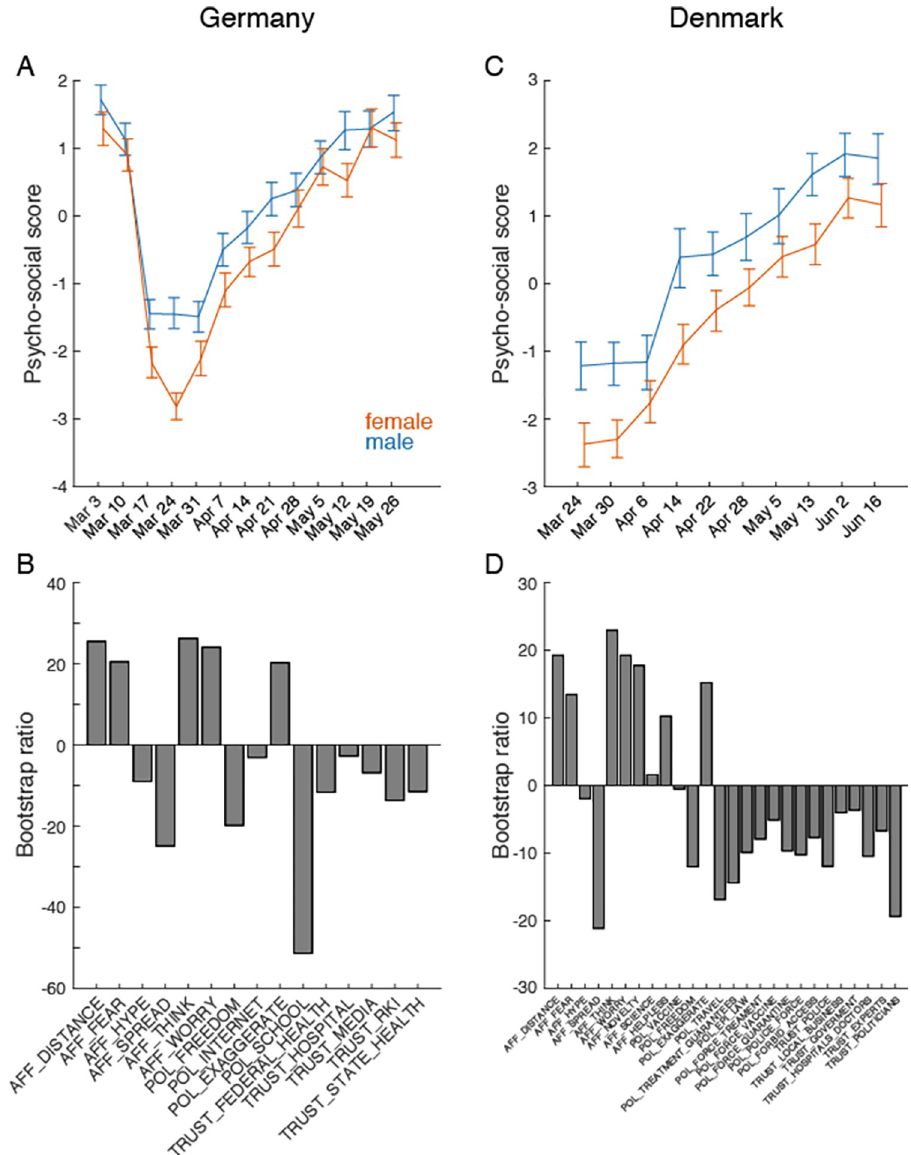
Fig 5. Sex differences in PS indicators. The dominant effect (both p < 0.001 from permutation test) of a multivariate Partial Least Squares analysis of mean change over time of PS indicators in COSMO data from Germany (A-B) and Denmark (C-D) by sex. AFFECT (AFF), POLICY (POL) and TRUST variables were included if data were available from all waves in each of the COSMO datasets. See Table A in S1 Text in Supplementary Information for a complete list of variables. Error bars: Bootstrap estimated 95% CI. Bootstrap ratios are the singular value weights divided by their standard error and are roughly equivalent to a z-score. The shape of the Psychosocial score curve relative to the PS Indicators suggests an increase in affect risk perception and great institutional and policy trust in March, followed by a general relative reduction.